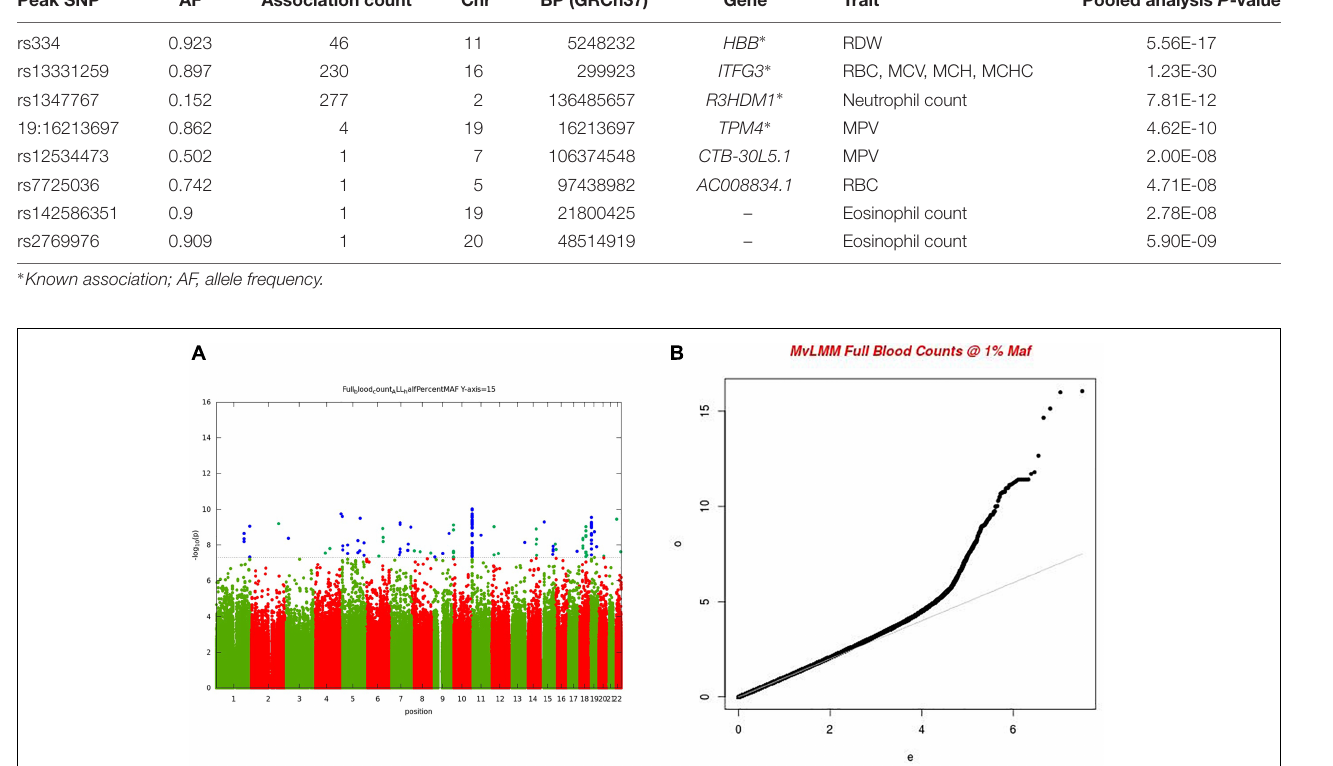
TABLE 2 | Description of genome-wide significant loci using the standard univariate GWAS approach. Peak SNP